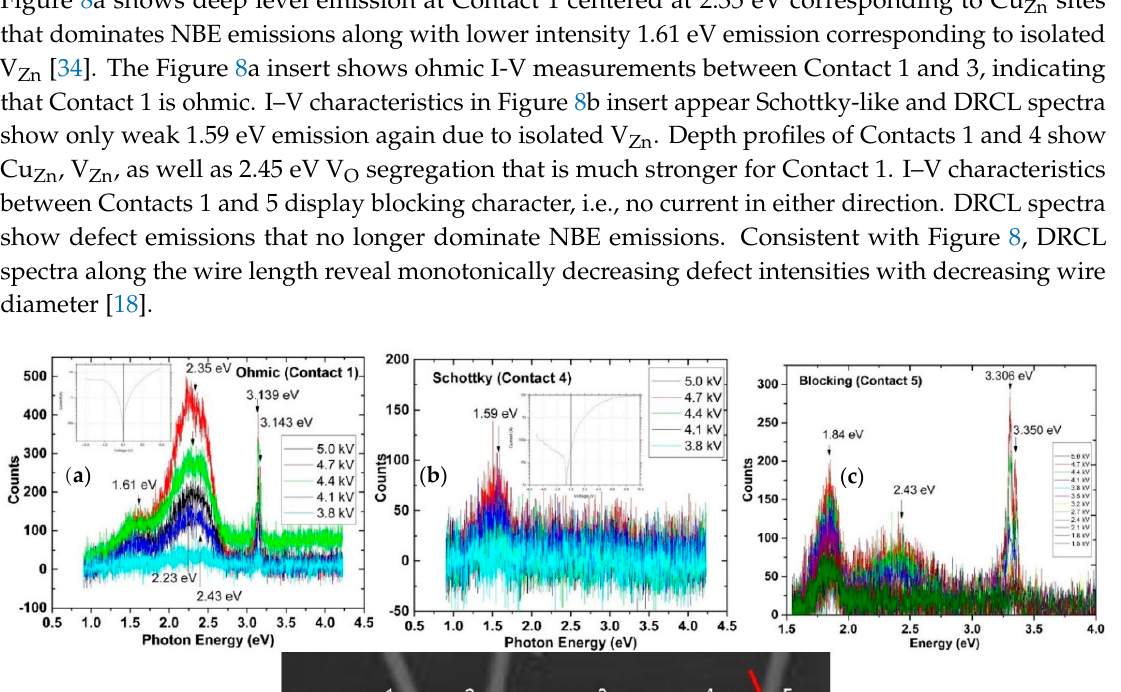
Figure 7. Defect segregation below a ZnO single crystal free surface versus crystal orientation. ( a ) [000ī] V O (2.5 eV) and ( b ) [112-0] V Zn (1.7–2.1 eV) and V O (2.4–2.5 eV) segregation. Higher V O segregation in O- vs. Zn-polar ZnO also shown in ([52]) Reprinted with permission by American Institute of Physics Refs. ([51–53], respectively).